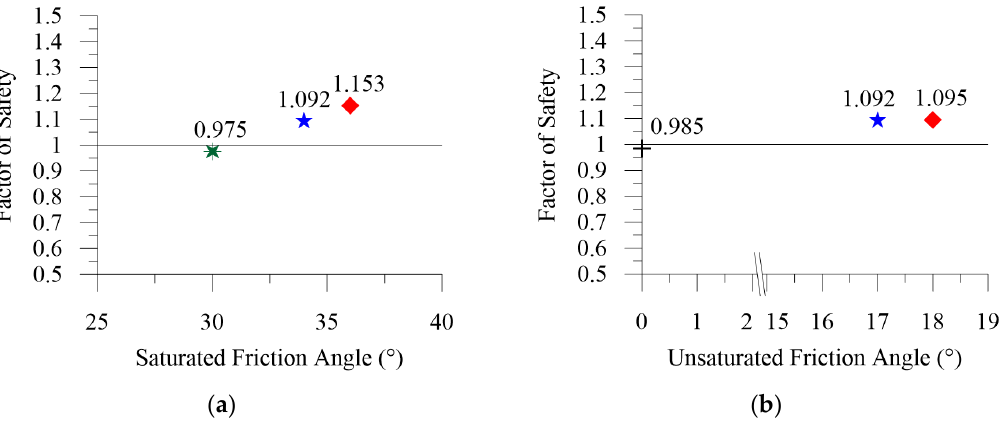
Figure 12. Factor of safety variation versus saturated friction angle ( a ) and unsaturated friction angle ( b